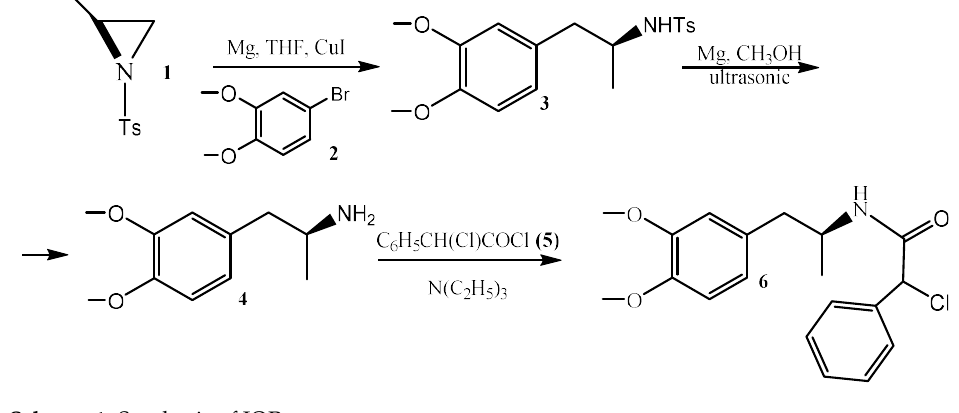
Figure 2. Chemical structures of papaverine and IQP.